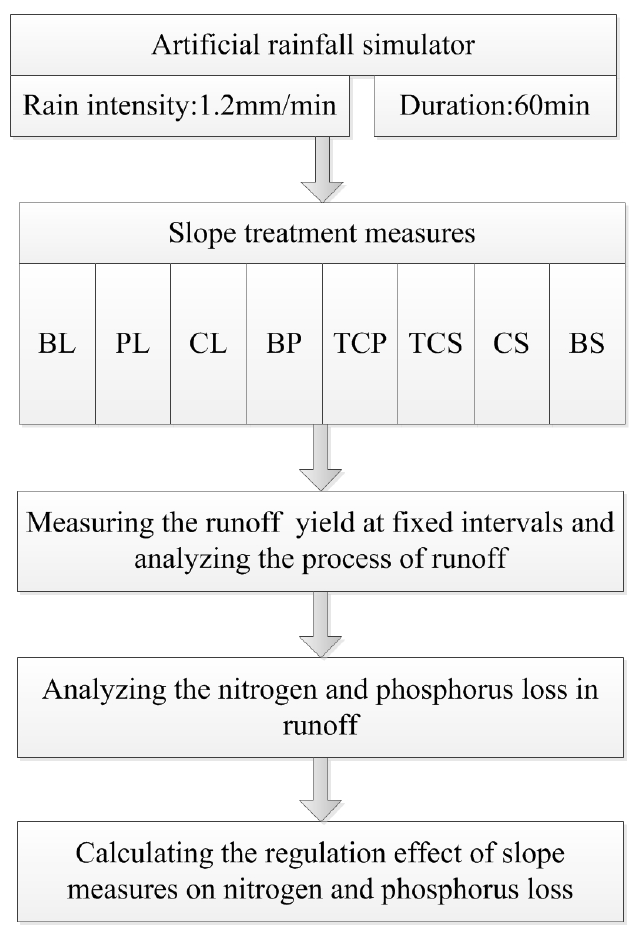
Figure 3. Flow chart of artificial rainfall experiments. The abbreviations in the figure denote different slope treatments, and the full name of each abbreviation is provided in Table 1.